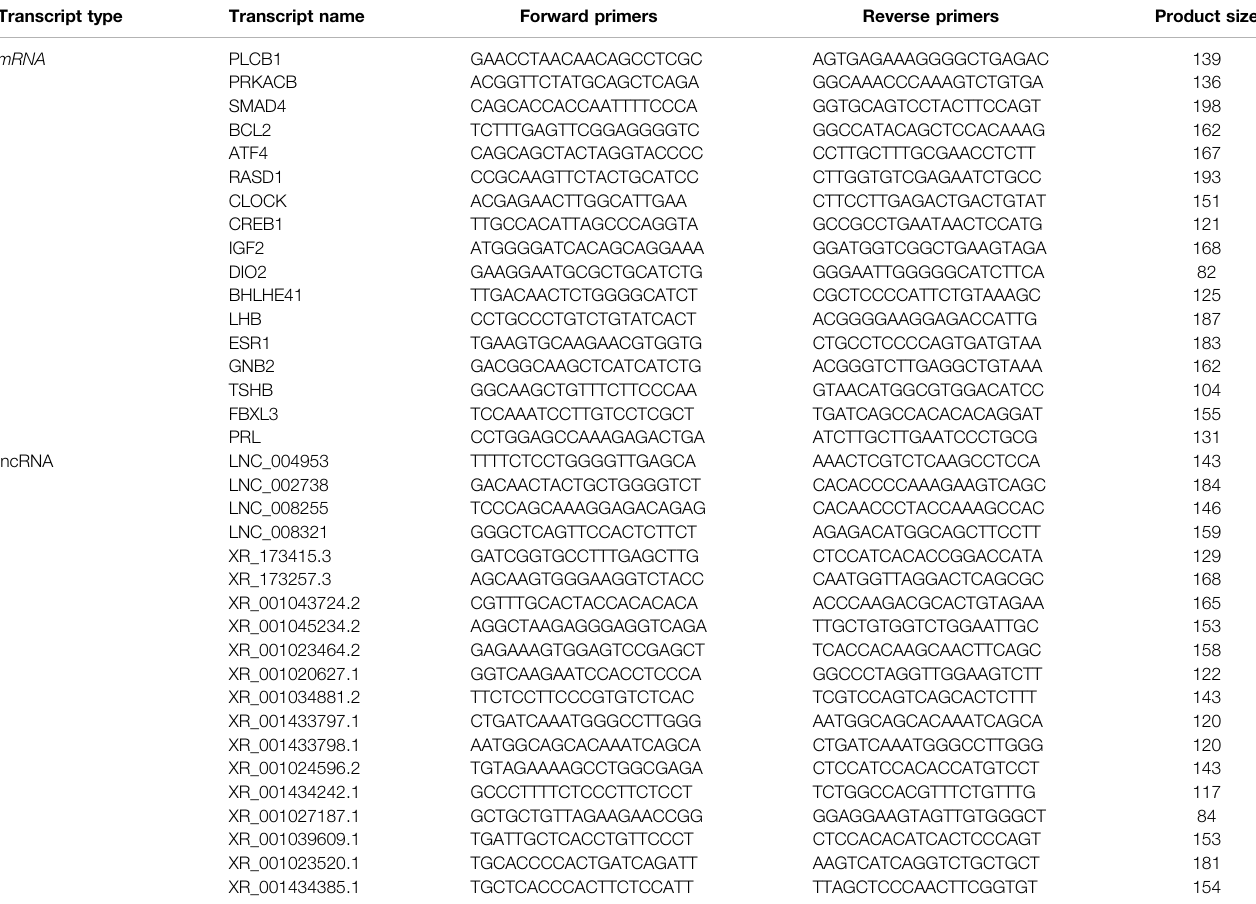
TABLE 1 | Primers of the validation of differentially expressed mRNAs and